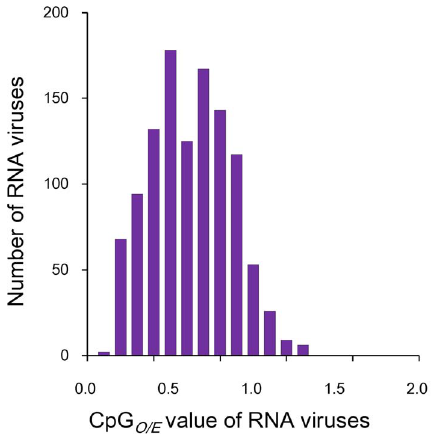
Figure 1. CpG usage pattern of RNA viruses. The y -axis depicts the number of viruses with the specific CpG O/E values given on the x